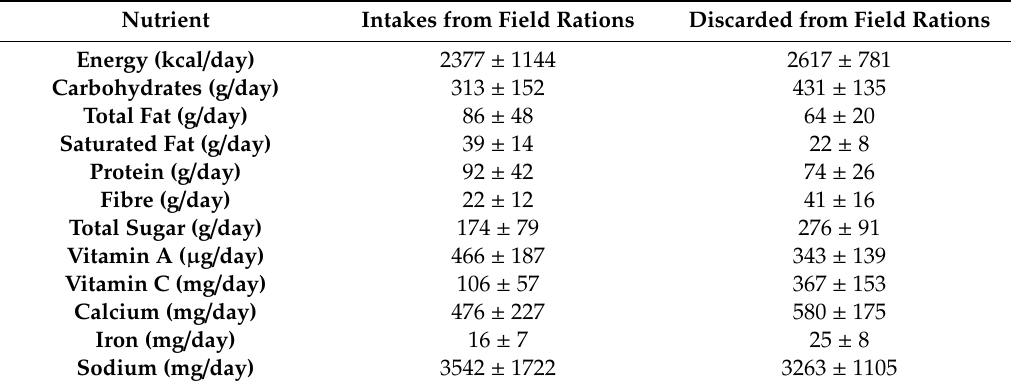
Table 3. Energy and nutrient intakes from field ration consumed and discarded during the arctic-like field training exercise (n = 10).